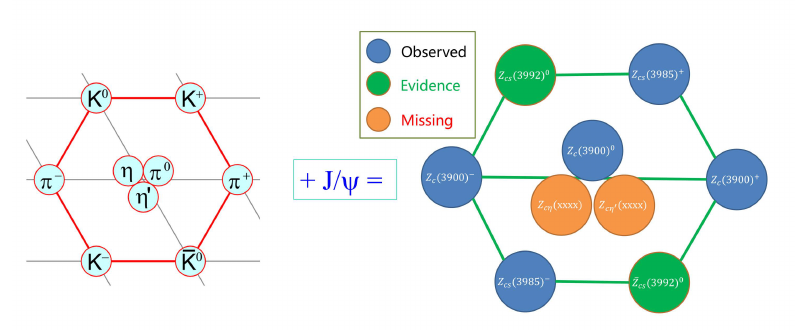
Figure 8. The similarity of the pseudoscalar nonet and the J P = 1 + Z c